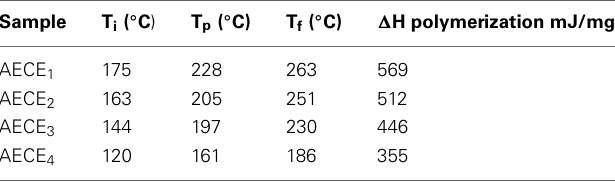
Table 1 | Curing studies of AECE monomers.